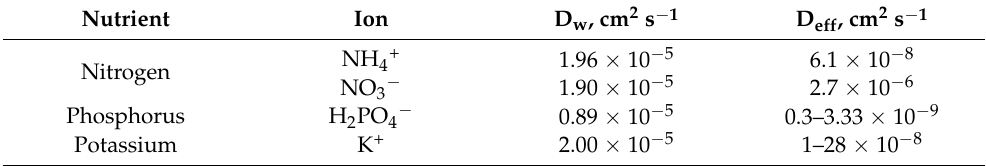
Table 3. Coefficients of effective diffusion for main nutrients in water and soil solution 1